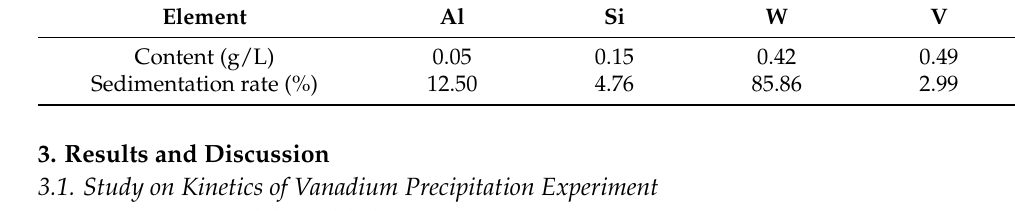
Table 4. Element content and precipitation efficiency after tungsten